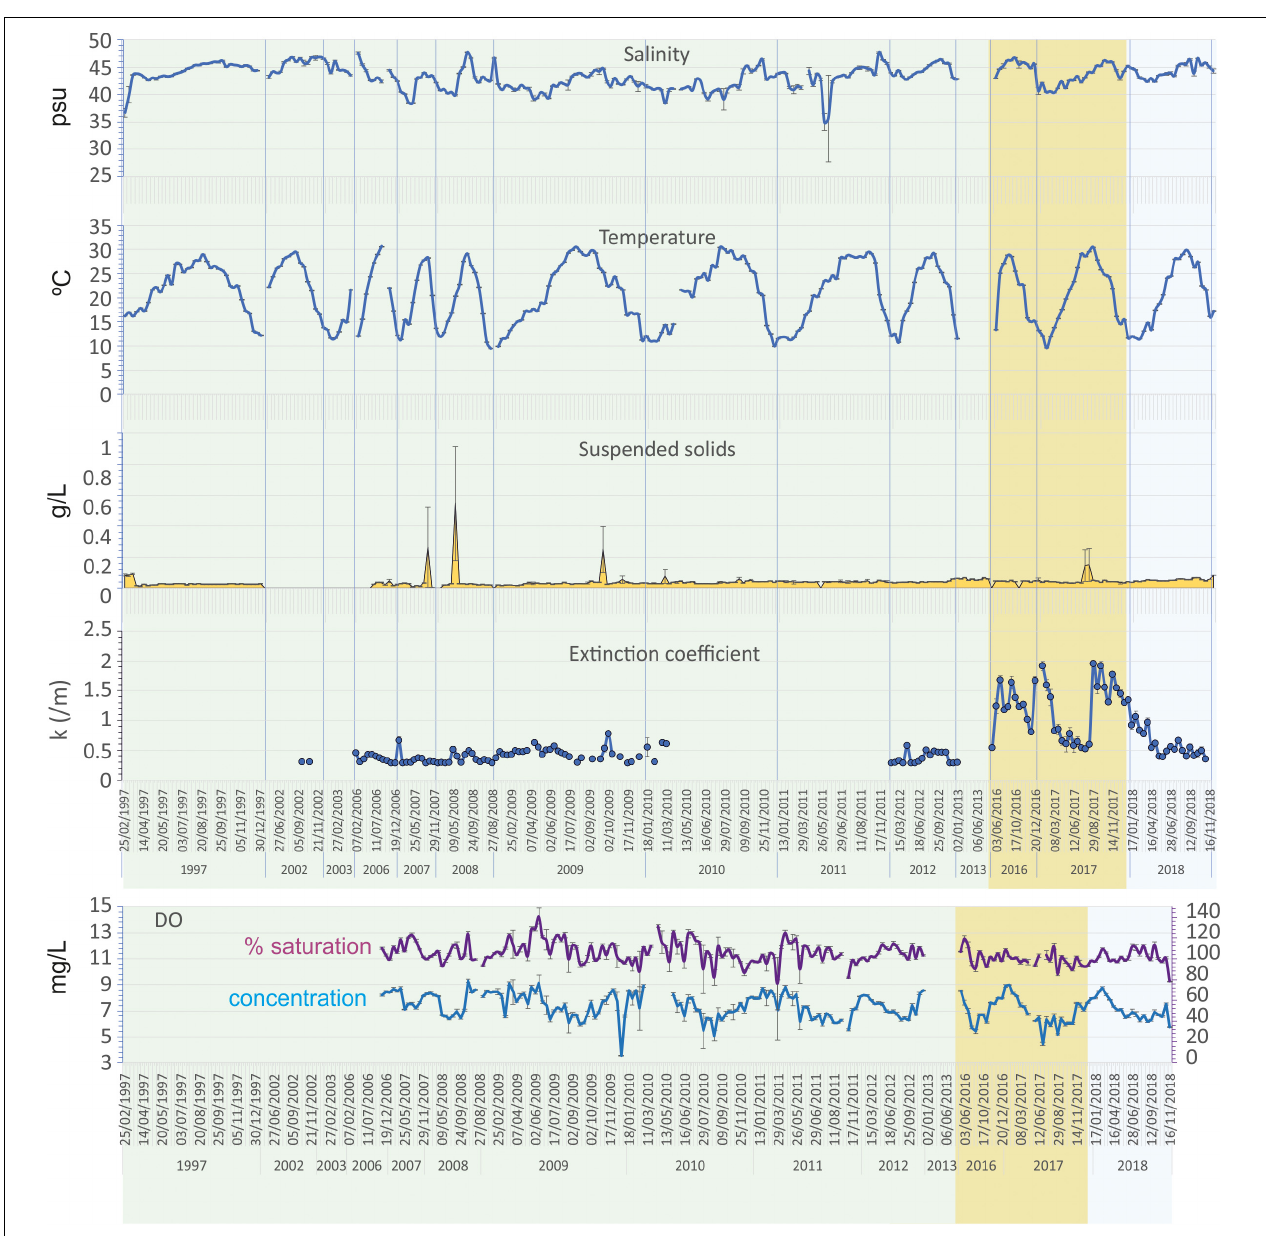
FIGURE 3 | Evolution of the main hydrographic variables during the study period in the Mar Menor lagoon water column. Prebreak phase is highlighted in green, Break phase in ochre, and Recovery in light